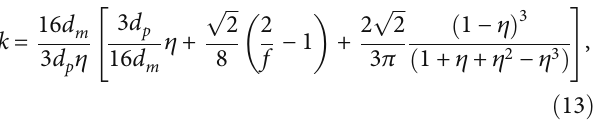
Figure 9: Stress model near the wellbore of horizontal